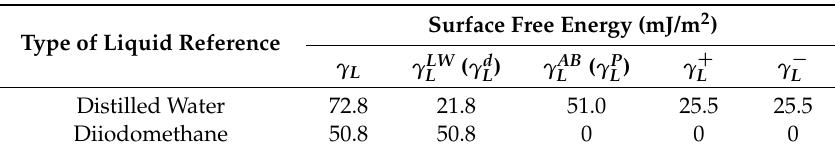
Table 1. Surface Tension and Components of the Test